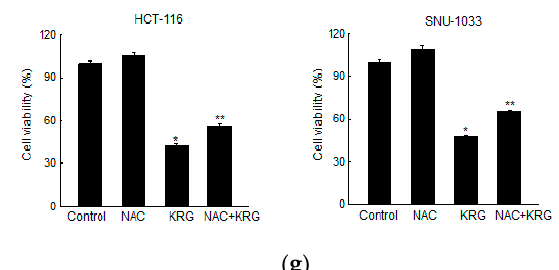
Figure 4. KRG extract induces autophagy-mediated cell death via generation of mitochondrial ROS. Cells were incubated with the KRG extract (2.0 mg/mL in HCT-116; 2.3 mg/mL in SNU-1033) in the presence or absence of NAC (1 mM) for 48 h. Mitochondrial ROS levels were assessed using ( a ) spectrofluorometry, ( b ) flow cytometry, and ( c ) fluorescence microscopy after DHR 123 staining. Scale bar, 20 µ m. * p < 0.05 vs. untreated control; ** p < 0.05 vs. the KRG extract-treated cells. The KRG extract-induced autophagy was assessed using ( d ) flow cytometry and ( e ) fluorescence microscopy after acridine orange staining. Scale bar, 10 µ m (HCT-116) and 20 µ m (SNU-1033). * p < 0.05 vs. untreated control; ** p < 0.05 vs. the KRG extract-treated cells. ( f ) Apoptotic sub-G 1 DNA content was detected and quantified using flow cytometry after PI staining. * p < 0.05 vs. untreated control; ** p < 0.05 vs. the KRG extract-treated cells. ( g ) Cells were incubated with the KRG extract (2.0 mg/mL in HCT-116; 2.3 mg/mL in SNU-1033) in the presence or absence of NAC (1 mM) for 48 h, and cell viability was assessed using the MTT assay. * p < 0.05 vs. control; ** p < 0.05 vs. the KRG extract-treated cells. We evaluated ginsenosides Rb1, Rc, Rg2, and Rg3, which are the top four most abundant ginsenosides in the KRG extract, for their effects on autophagy-mediated cell death or apop- tosis of colon cancer cells. As shown in Figure 5a, ginsenosides suppressed the proliferation of HCT-116 and SNU-1033 cells in a concentration-dependent manner, and Rg2 was found to be the most effective in both the cell lines. The fluorescence intensity of acridine orange in gin- senoside Rg2-treated cells was higher than that in other ginsenoside-treated cells (Figure 5b). In addition, ginsenoside Rg2 was the most effective inducer of apoptosis among the ginseno- sides, as indicated by the formation of apoptotic bodies (Figure 5c).